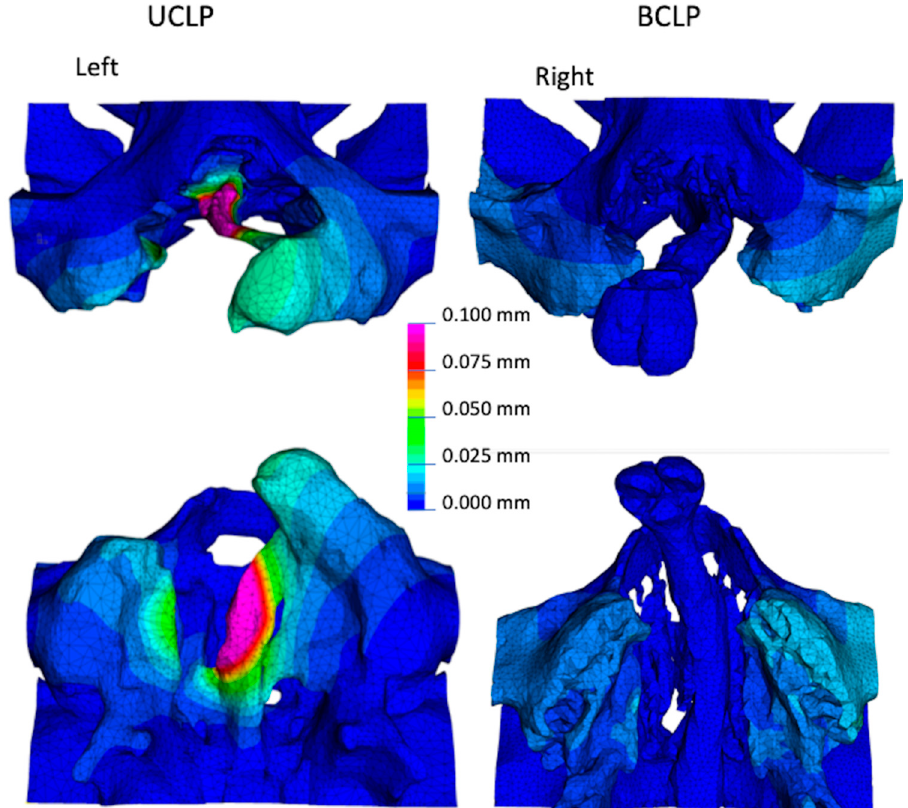
Figure 3. Distribution of the overall periosteal deformation in mm for 5 N loading in the UCLP (left column) and BCLP (right column) models. Frontal (top row) and palatal (bottom row) views are shown.